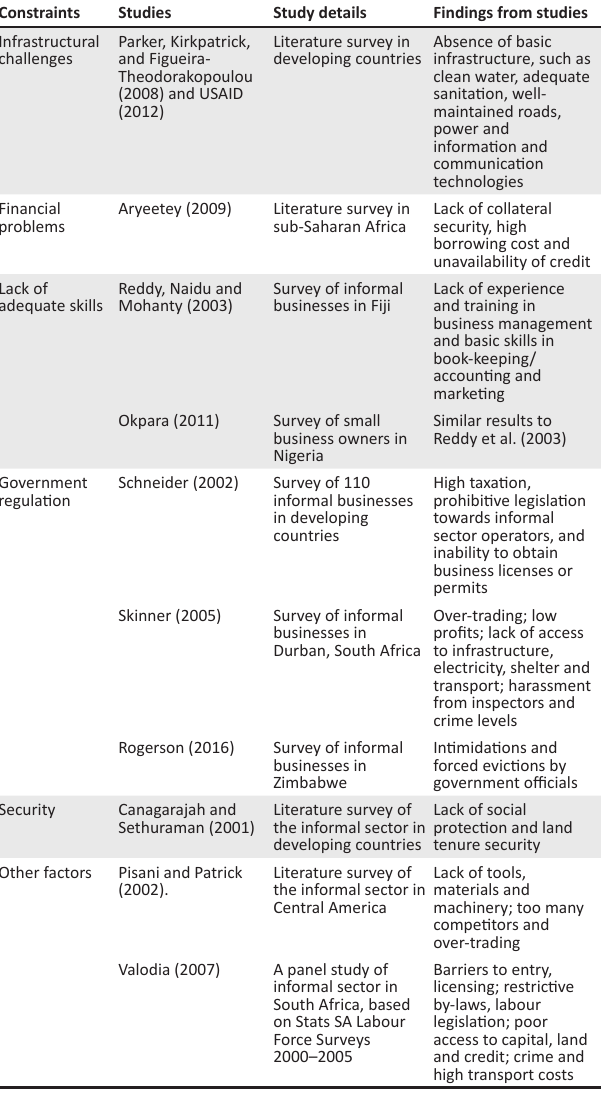
TABLE 1: Growth constraints in the informal sector.